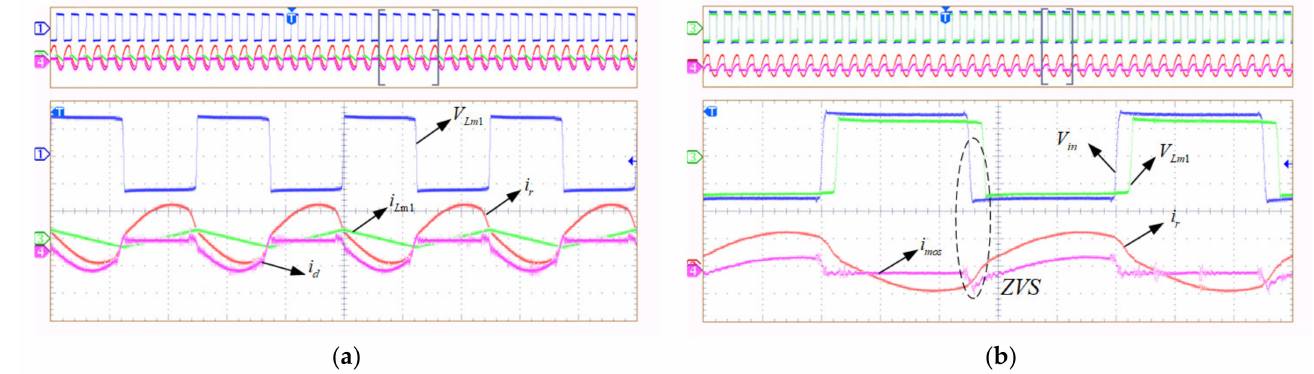
Figure 17. Experimental waveform when switching frequency is greater than the resonant frequency, and ( a , b ) show the corresponding current of the diode and low-voltage side MOS tube,